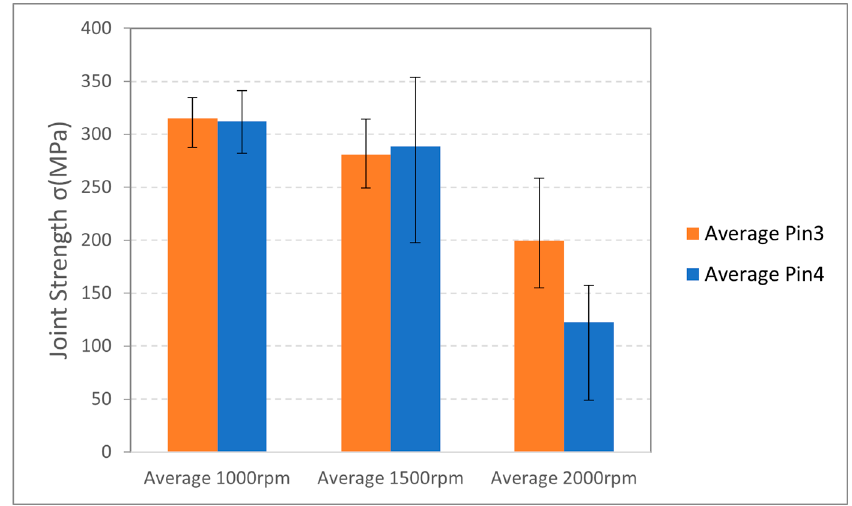
Figure 9. Comparison of tensile strength for joints for three different rotational speeds.